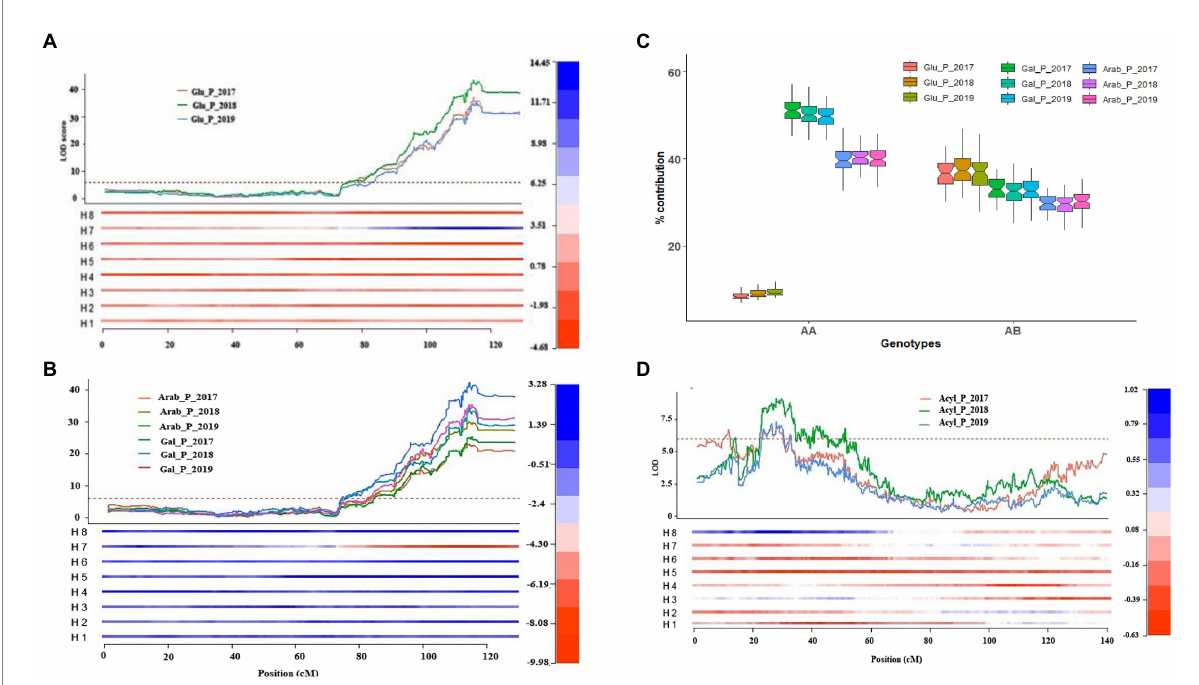
FIGURE 5 Major-effect QTLs identified for anthocyanin glycosylation and acylation mapped on chromosomes 2 and 4. (A) Representation of a major-effect locus mapped on chromosome 4 that increased the amount of glucoside containing anthocyanins; (B) Representation of a major-effect locus mapped on chromosome 4 that reduced the amount of galactoside/arabinoside containing anthocyanins; (C) Boxplot illustrating the present (AB) and absent (AA) effects of the major – effect locus mapped on chromosome 4 using simplex SNP marker, Chrom04_60364575; (D) Representation of a major-effect QTL mapped on chromosome 2 that increased acylation of anthocyanins. The heatmap represents the effect of each homolog relative to the overall phenotypic mean performance. The H1–H8 represents the eight homologs with the first four homologs (H1–H4) inherited from the parent ‘Draper-Selection _44392’ and the other four homologs (H5–H8) inherited from the parent